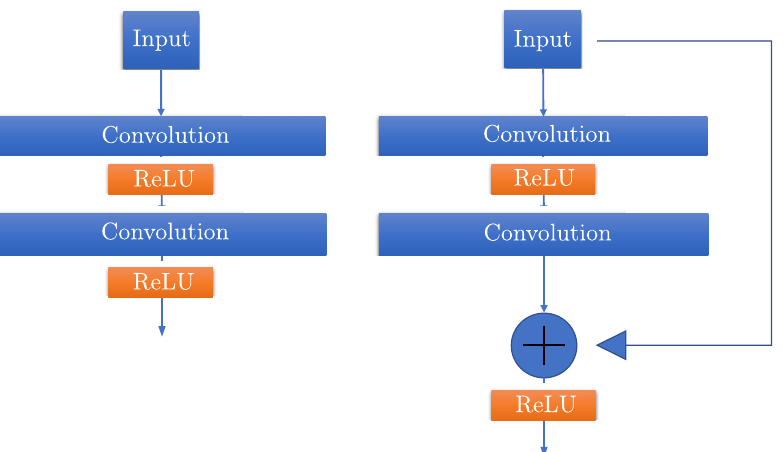
Figure 2. ( Left ): Convolution and ReLU convolution block utilized by the U-Net architecture. ( Right ): Residual block adding the initial information to the convolution and ReLU